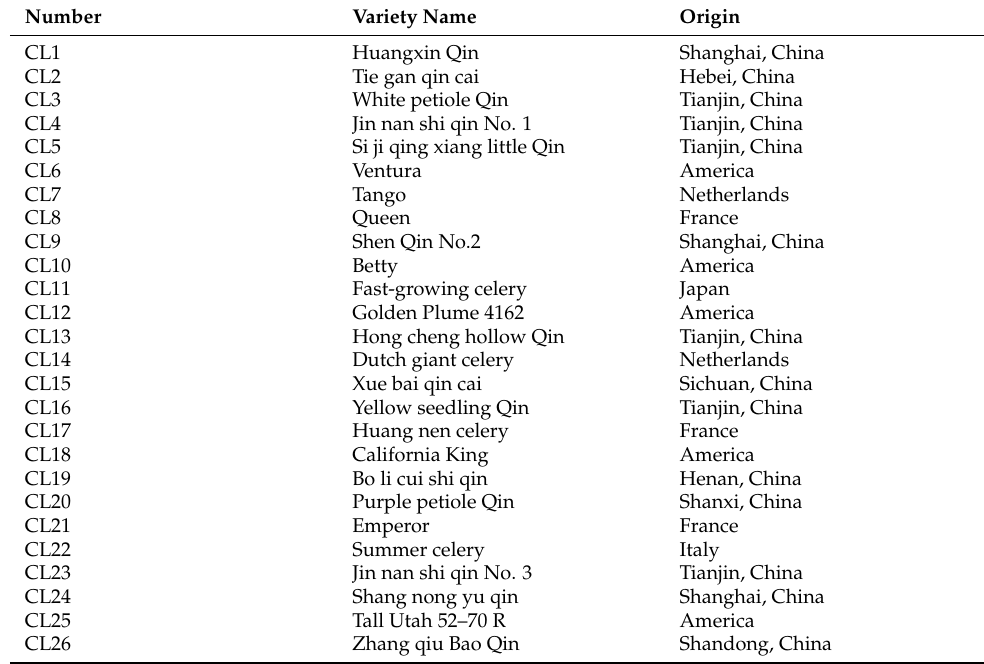
Table 1. The names and origins of 26 celery